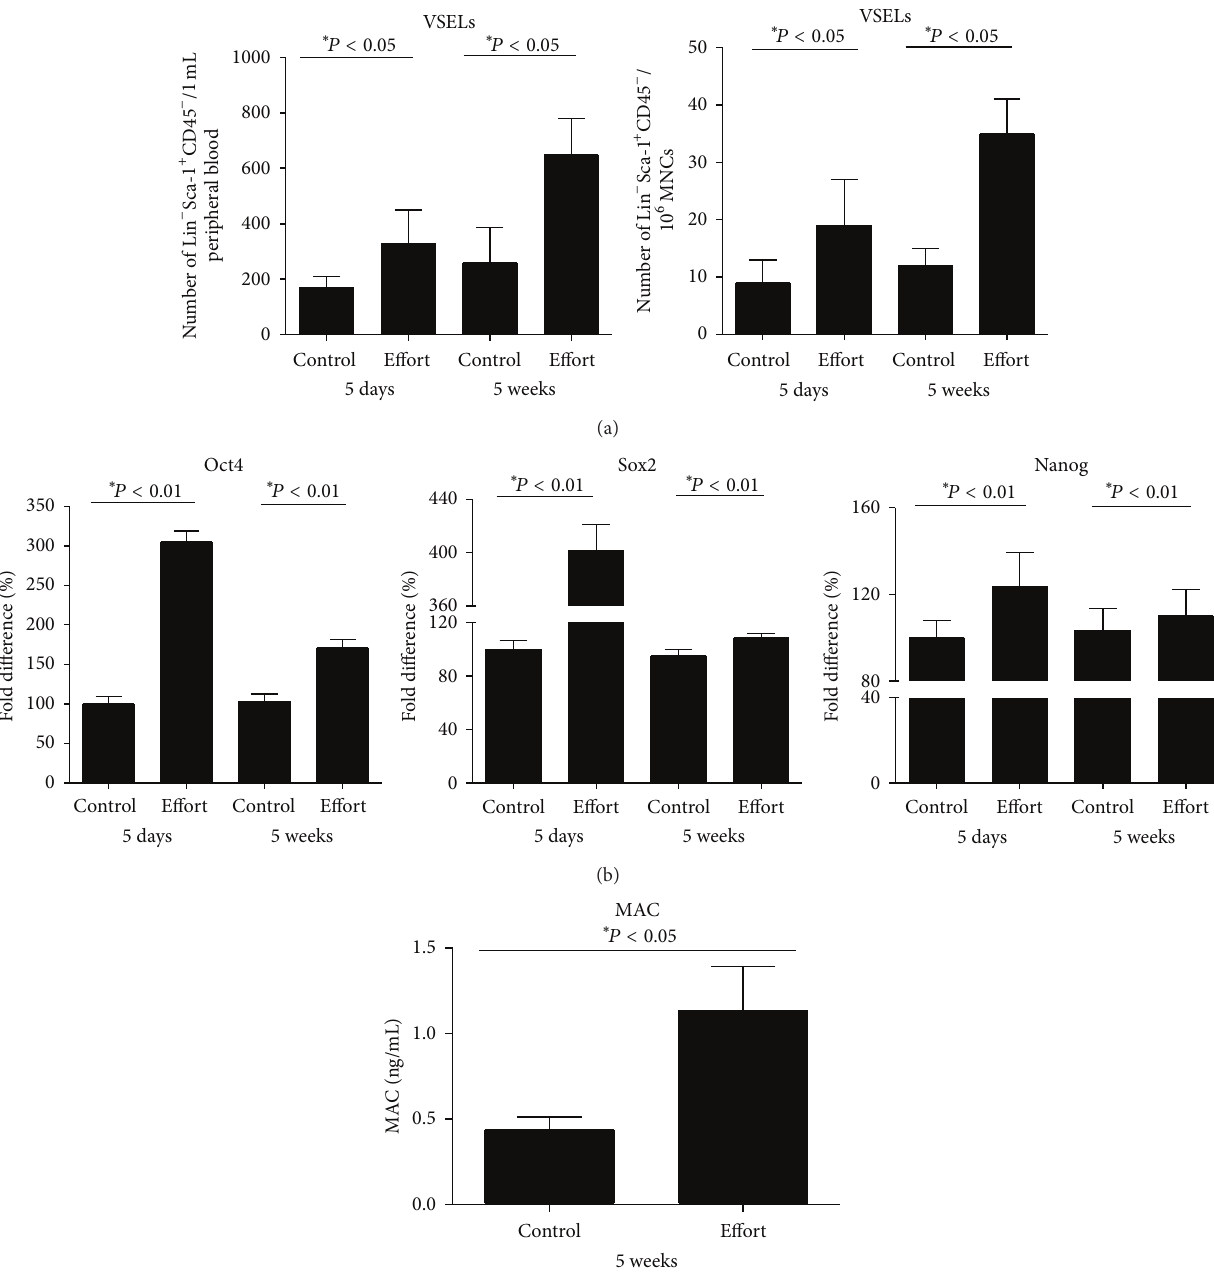
Figure 2: Effect of 5 days or 5 weeks of exercise on a treadmill on the number of VSELs in PB and BM. (a) The number of VSELs circulating in PB (left panel) and BM (right panel) after 5 days or 5 weeks of exercise on a treadmill (effort) compared with nonexercising mice (control). (b) Quantitative real-time PCR changes in expression of Oct4, Sox2, and Nanog in PB mononuclear cells after 5 days or 5 weeks of exercise on a treadmill (effort) compared with nonexercising mice (control), whose expression level was defined as 100%. (c) Activation of the complement cascade in PB measured by C5b-C9 (MAC) ELISA after 5-week exercise on a treadmill (effort) compared with nonexercising mice (control) ( 𝑛 = 6